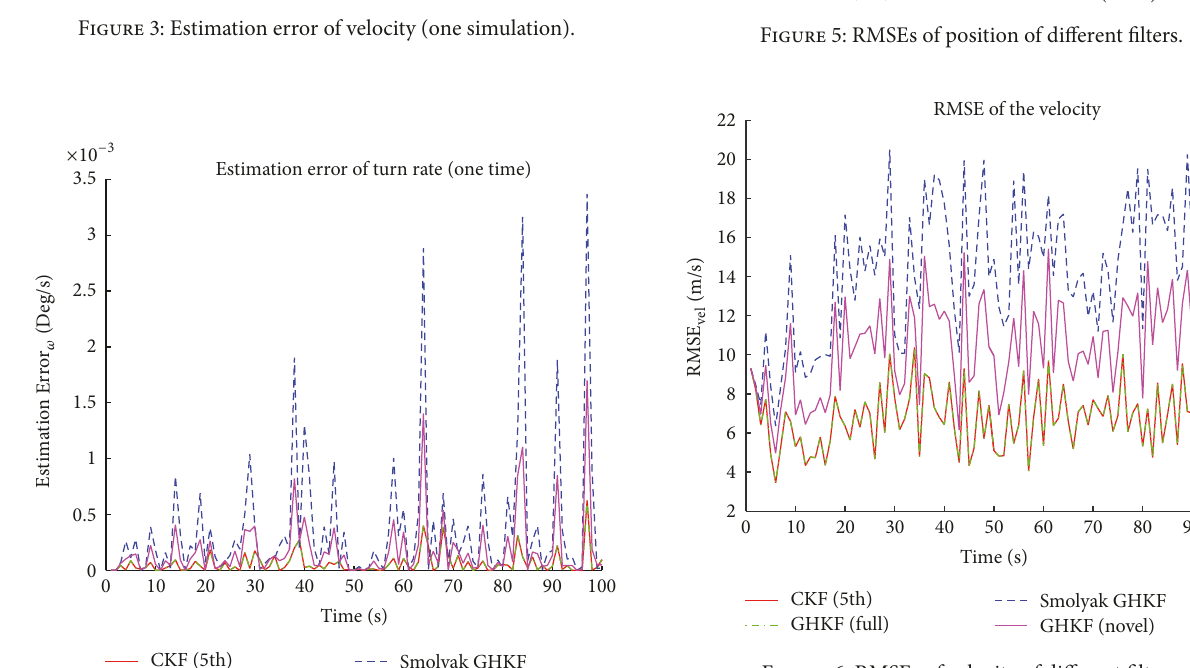
Figure 6: RMSEs of velocity of different